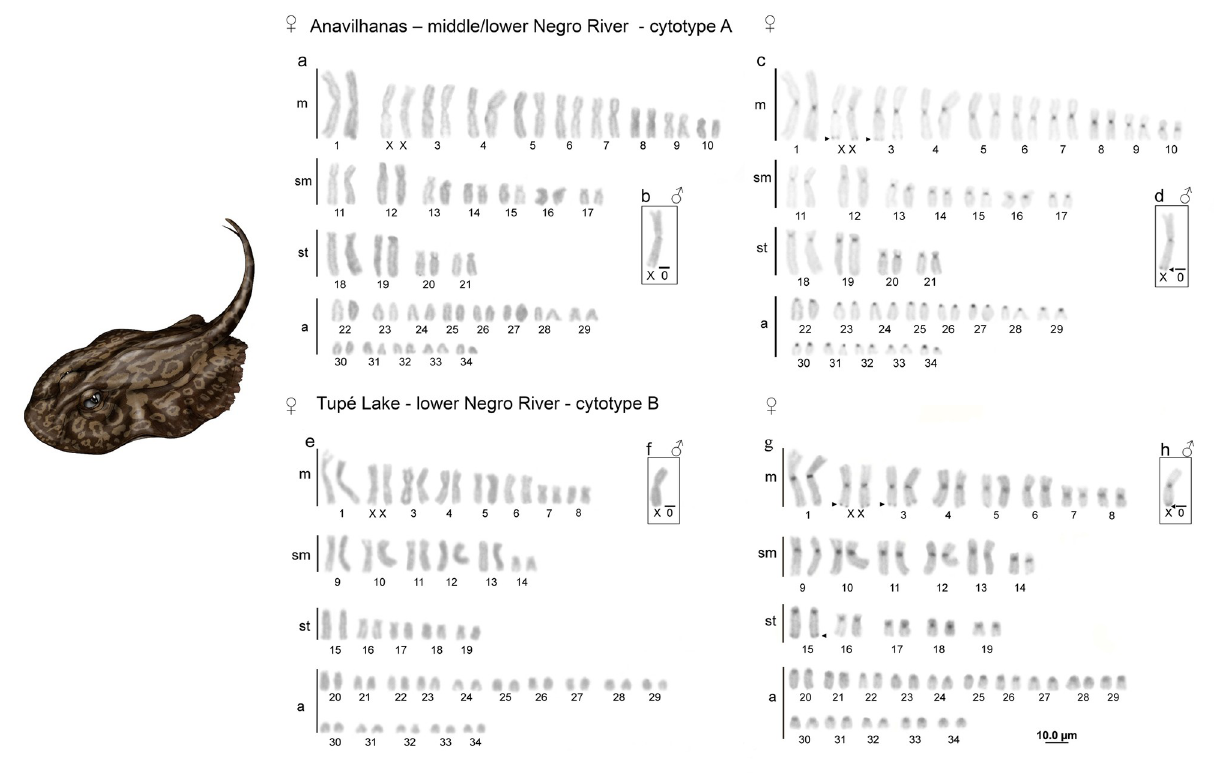
Fig 1. Giemsa and C-banding karyotypes. Giemsa and C-banding karyotypes from Anavilhanas population (a-d)–cytotype A. Giemsa and C-banding karyotypes from Tupe´ population—cytotype B (e-h) triangles indicating terminal heterochromatic regions. Illustration by Lucas Kı´as.